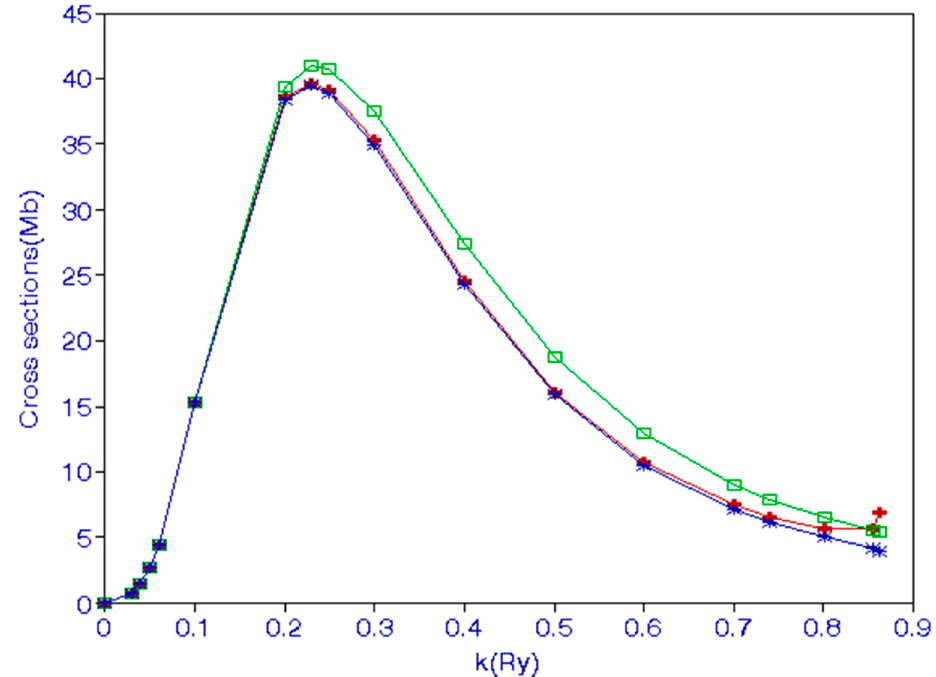
Figure 1. Photodetachment of a hydrogen negative ion. The lowest curve is obtained when only the long-range correlations in Equation (15) are included; the middle curve is obtained when the short-range and long-range correlations are included in Equation (15). The top curve is obtained for cross sections obtained by Ohmura and Ohmura using the effective range theory, Equation (17).